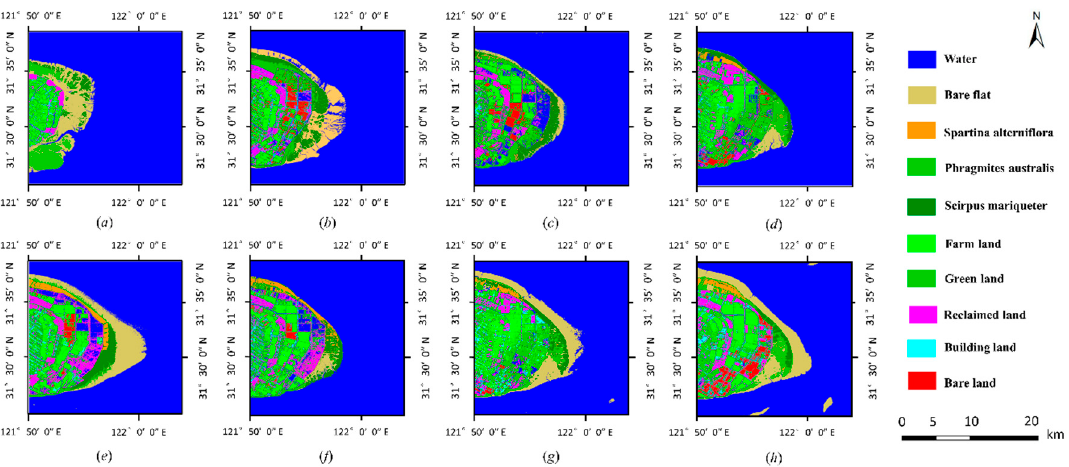
Figure 4. Classification results of K-ELM: ( a ) 1986; ( b ) 1990; ( c ) 1995; ( d ) 2000; ( e ) 2003; ( f ) 2007; and ( g ) 2009; ( h ) 2013.